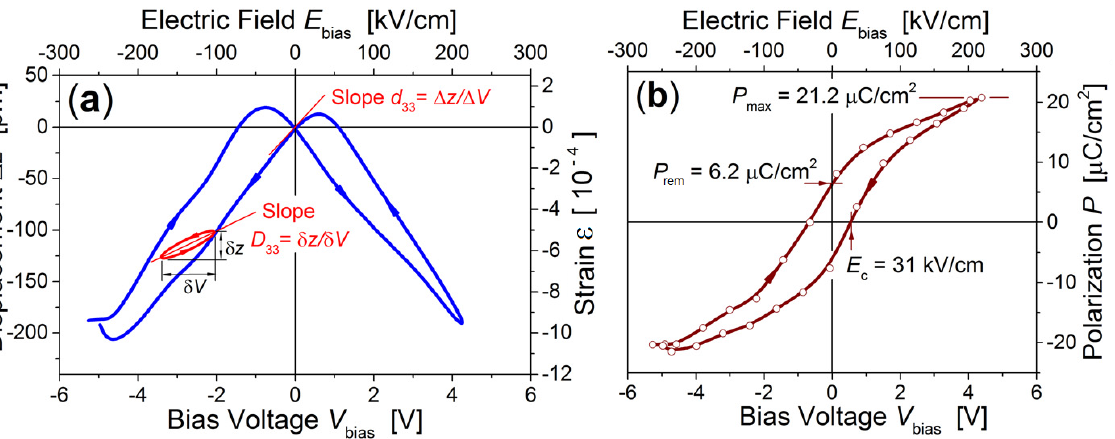
Figure 5. Electrostriction effect recorded with the Asylum Research MFP-3D AFM in individual NKN nanofiber. ( a ) Strain ε and displacement Δ z vs. bias voltage curve. Piezoelectric coefficient d 33 is obtained as a slope of the butterfly loop at zero bias. Minor loop schematically shows how the “incremental” piezoelectric coefficient D 33 can be experimentally revealed. ( b ) Hysteresis polarization P – E loop reconstructed from the butterfly displacement –voltage Δ z – V bias curve. Reproduced from [22] with the permission of AIP Publishing.